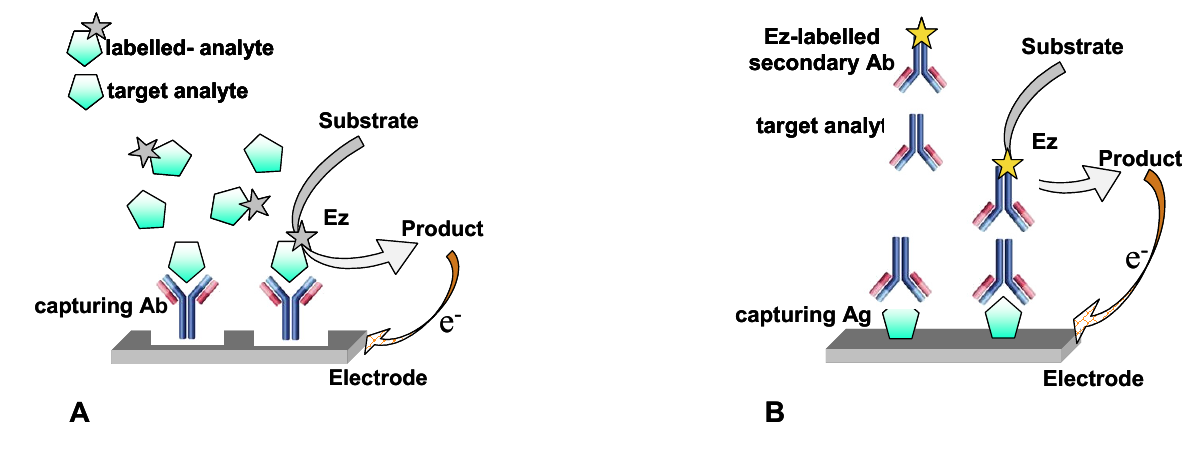
Figure 5. Scheme depicting different immunoassay formats using amperometric detection. (A) Biosensor to detect an antigen using a competitive immunoassay format, with a redox-enzyme-labelled antigen and the natural substrate of the enzyme, Ez. (B) Biosensor to detect a specific antibody using an indirect immunoassay